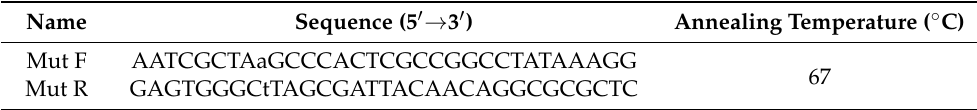
Table 14. Primers for C to A mutation in SP1 binding